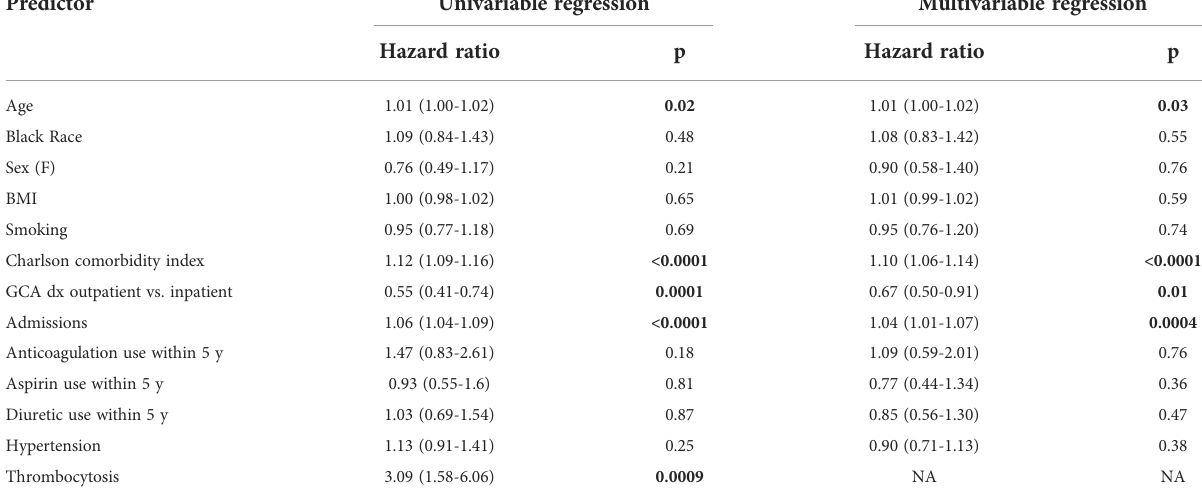
TABLE 3 Predictors for the incidence of DVT after diagnosis of